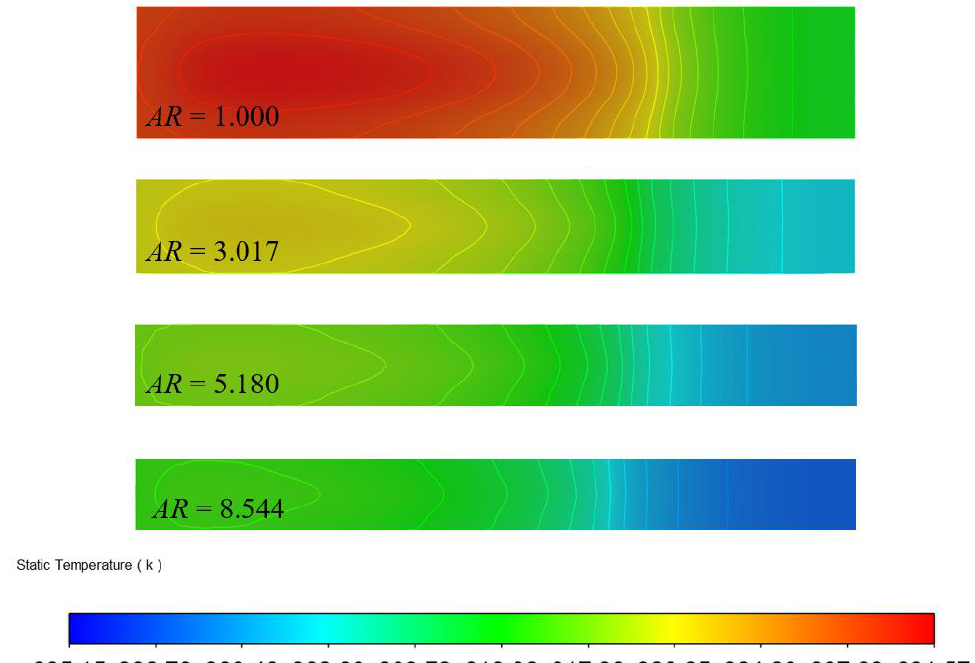
Figure 8. Temperature distribution along x–z of the top of microchannel heat sinks with different aspect ratios ( W pp = 0.2 W, Temperature unit: K).